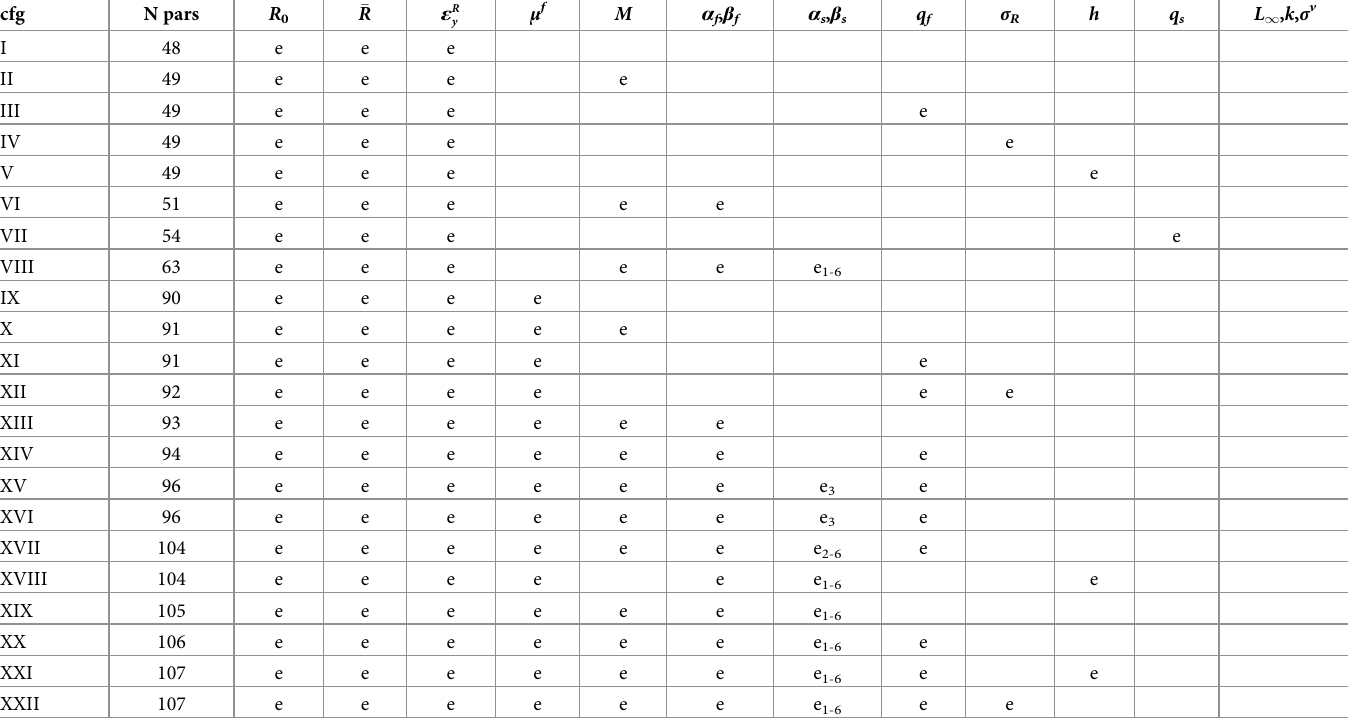
Table 2. Parameter groupings that were estimated ("e") in each of 22 configurations (“cfg”) (cid:3) . All configurations were initialized using the parameter values from Table 1. Configurations are ordered by increasing numbers of estimated parameters ("N